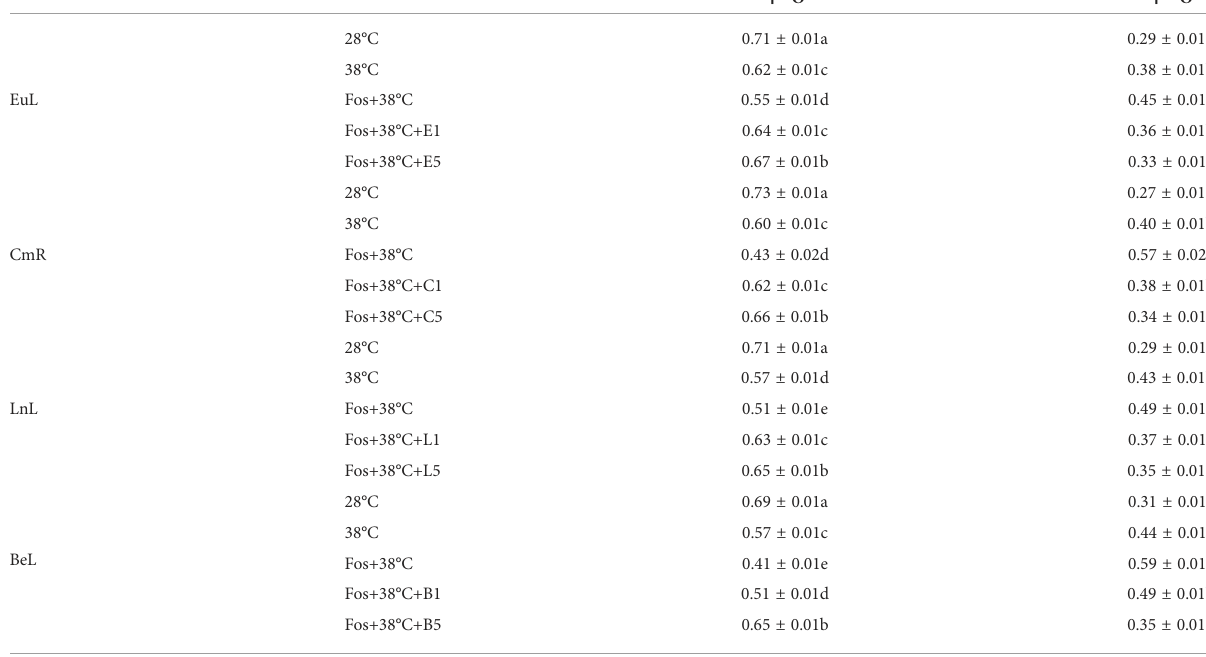
TABLE 2 Effects of the uppermost monoterpenes on maximum quantum yield of primary photochemistry ( j P O ) and non-photochemical deexcitation ( j D O ) in C. camphora .